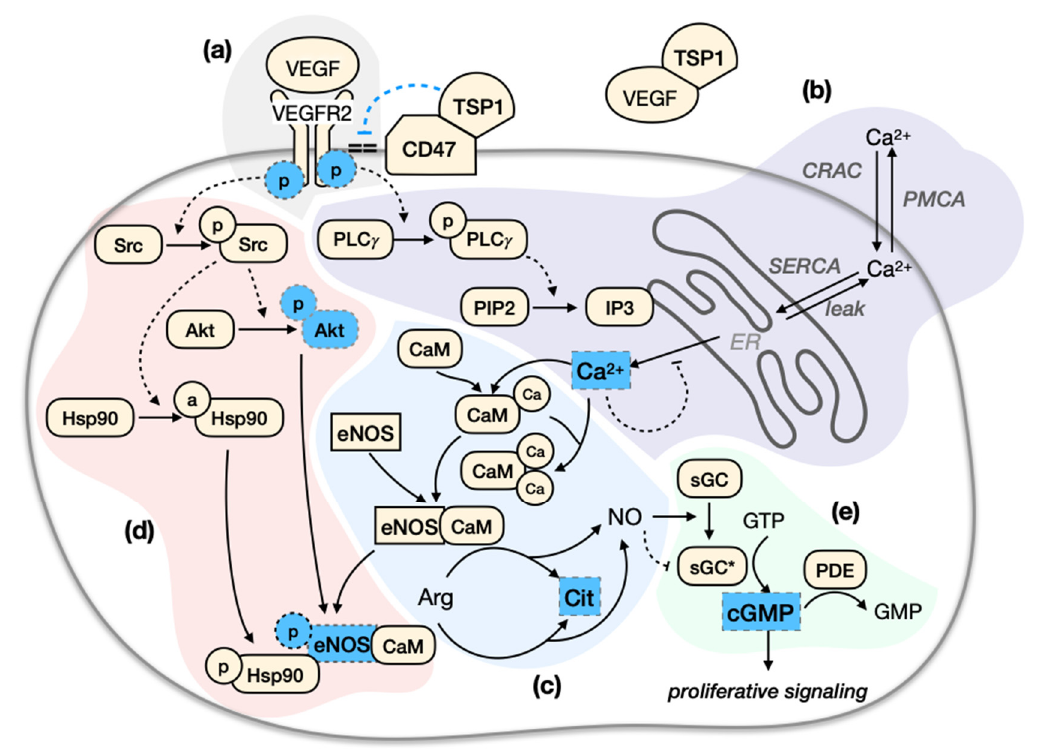
Figure 1. Model Schematic. ( a ) Receptor module. The signaling pathway begins with VEGF binding to receptor R2. Ligated R2 undergoes autophosphorylation and triggers the phosphorylation of Src and PLC γ . ( b ) Calcium module. Active PLC γ converts PIP 2 to IP 3 through hydrolysis. IP 3 binds to its receptor on the ER membrane and induces Ca 2+ release into the cytosol. The ER store Ca 2+ depletion triggers further Ca 2+ entry through the CRAC channel which is quickly balanced by several homeostatic mechanisms. ( c ) eNOS module. Ca 2+ binds to and activates CaM, which in turn activates eNOS. eNOS converts its substrate arginine to citrulline, producing NO. ( d ) Src/Akt/Hsp90 module. Active Src activates Akt and the chaperon protein Hsp90. Hsp90 facilitates Akt association with eNOS, which results in eNOS phosphorylation. The binding of eNOS with Hsp90 and phosphorylation of eNOS both enhance eNOS activity. ( e ) sGC module. NO triggers cGMP synthesis from GTP. cGMP is degraded by PDE. TSP1 sequesters VEGF in the extracellular space and binds to its own receptor CD47 on the EC membrane, disrupting the coupling of CD47 and R2. Furthermore, TSP1 has been shown to reduce VEGF-induced activation of R2, Akt, and eNOS, agonist-stimulated Ca 2+ increase, basal eNOS activity, and basal or VEGF/agonist-induced cGMP production. The signaling species observed to be affected by TSP1 are highlighted in blue. Shading indicates the relative location of reactions in the network. Light red: Src/Akt/Hsp90; light purple: Ca 2+ system; light blue: eNOS activity; light green: sGC activity. Abbreviations: Akt, protein kinase B; CaM, Calmodulin; cGMP, Cyclic Guanosine Monophosphate; Cit, Citrulline; CRAC, Calcium Release-Activated Channels; eNOS, Endothelial Nitric Oxide Synthase; EC, Endothelial Cell; ER, Endoplasmic Reticulum; GMP, Guanosine Monophosphate; GTP, Guanosine Triphosphate; Hsp90, Heat Shock Protein 90; IP 3 , Inositol 1,4,5-Trisphosphate; PDE, Phosphodiesterase; PLC γ , Phospholipase C, Gamma; PIP 2 , Phosphatidylinositol 4,5-Bisphosphate; PMCA, Plasma Membrane Ca 2+ Atpase; NO, Nitric Oxide; SERCA, Sarco/Endoplasmic Reticulum Ca 2+ -Atpase; sGC, Soluble Guanylate Cyclase; sGC *, activated Soluble Guanylate Cyclase; Src, proto-oncogene tyrosine kinase Src; TSP1, Thrombospondin-1; VEGF, Vascular Endothelial Growth Factor; VEGFR2 or R2, Vascular Endothelial Growth Factor Receptor 2.